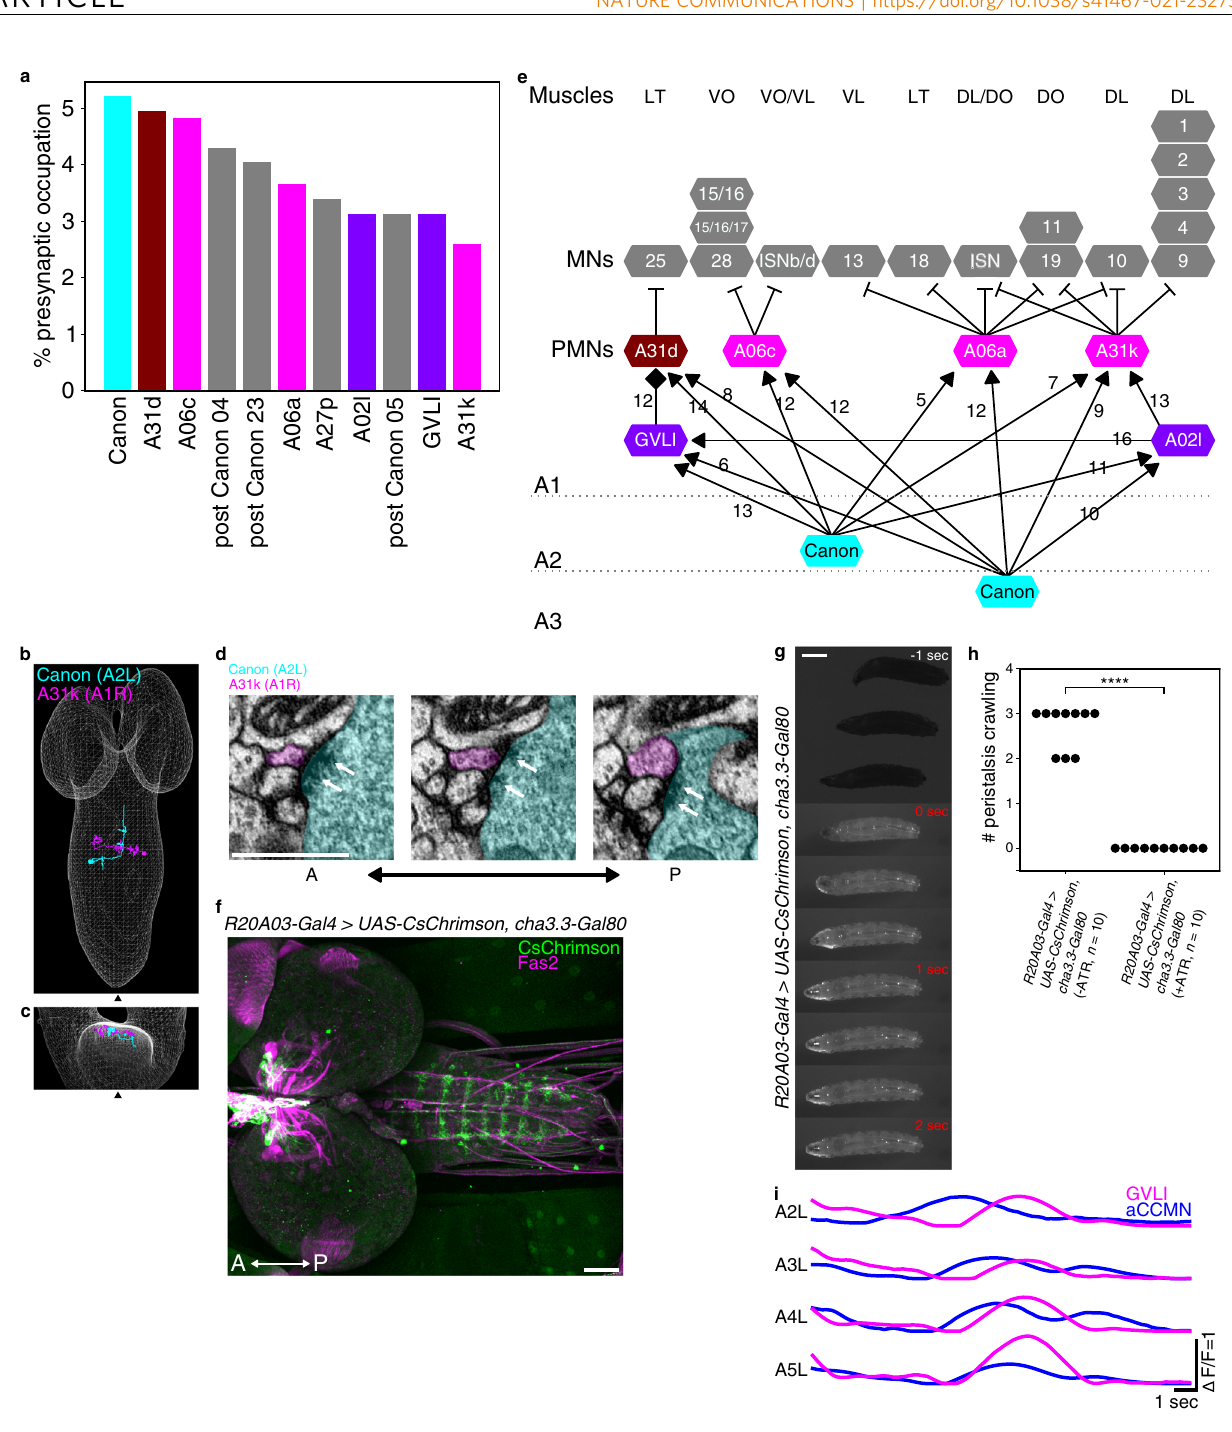
Fig. 5 Downstream circuits of Canon neurons. a A bar graph showing percent of total presynapses of A2 – A3 Canon neurons that target the indicated downstream neuron. Major partners (occupying more than 2.5% of total presynapses) are shown. b , c Dorsal view ( b ) and anterior view ( c ) of EM reconstructed A31k and Canon neurons. d Serial EM images showing synapses between Canon (cyan) and A31k (magenta) neurons. White arrows indicate T-bars. The images show representative synapses of observed 20 synapses from Canon to A31k neurons. e A circuit diagram from Canon neurons to muscles. Gray dotted lines indicate boundaries of neuromeres. Arrows with triangle heads indicate excitatory synaptic connections, lines with bar heads inhibitory synaptic connections and those with diamond-shaped heads glutamatergic synapses. Numbers next to the lines show the number of synapses. f Expression of CsChrimson driven by R20A03-Gal4, cha3.3-Gal80 . The image shows representative datum from one of three independent experiments that gave similar results. g Time-lapse images of experimental larvae during optogenetic activation. The larva halted immediately with its body relaxed when exposed to red light. 0 s represents the onset of photostimulation. h Quanti fi cation of the number of forward peristalses during the fi rst 2 s of light stimulation. n = 10 larvae in each group. All larvae in the experimental group stalled upon light stimulation, while control (ATR − ) larvae were unaffected. **** p < 0.0001. p = 1.08 × 10 − 5 , the two-sided Fisher exact test. i Plots of calcium signals in aCC MNs and GVLIs during fi ctive backward locomotion. Scale bars, 500 nm ( d ), 50 μ m ( f ), and 1 mm ( g